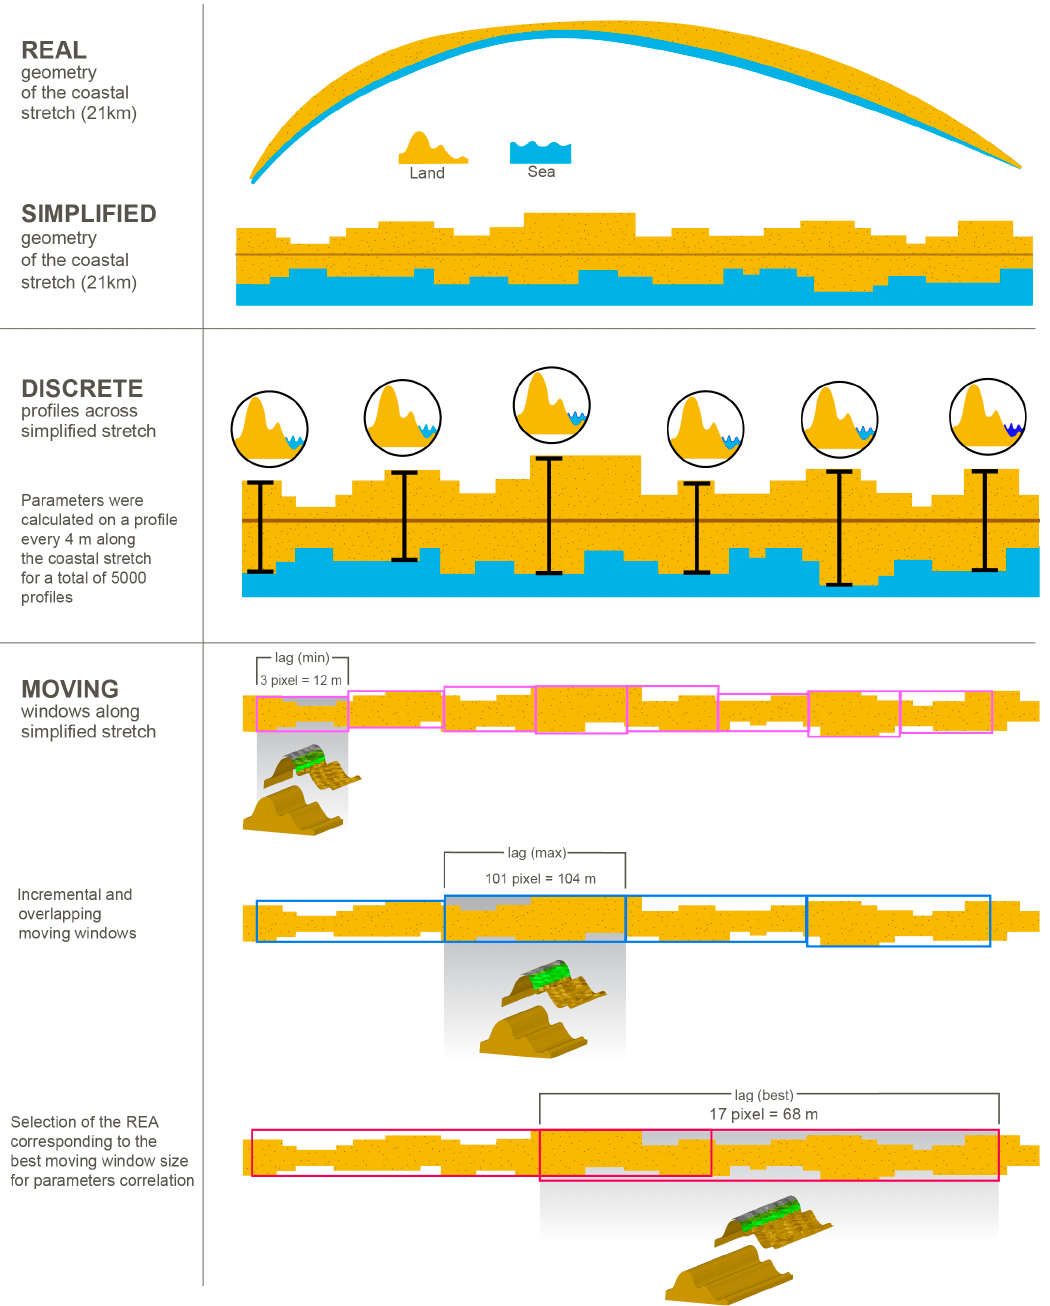
Figure 6. Graphical explanation of step 2 in Figure 4. The first section shows how the convex coastal stretch geometry is treated to obtain the simplified geometry for the continuous analysis. The second section shows how the 5000 transects are distributed. The third section shows how the moving windows size varies from 12 m = lag 3 to 404 m = lag 101, and the real elementary area (REA) of 68